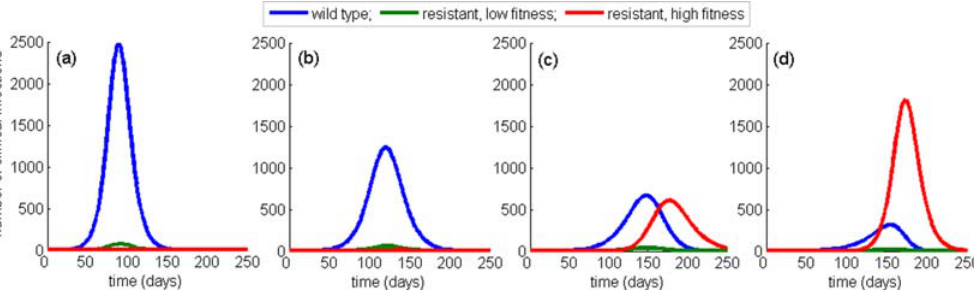
~ 1 : 6 . Simulations were 0 ~ 1 : 38 ; (b) R w ~ 1 : 25 ; (c) R w ~ 1 : 18 ; c c c